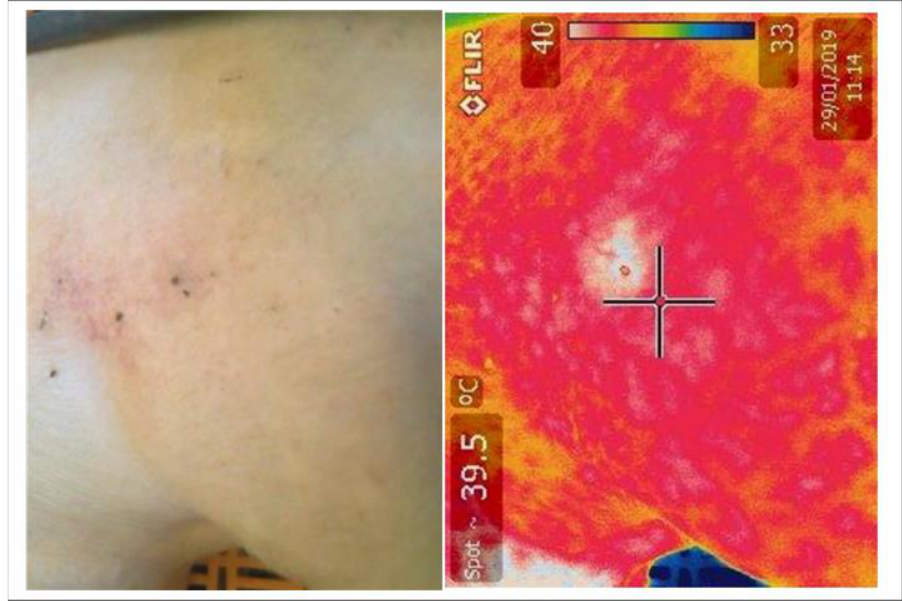
Figure 1. Thermal image of hotspots identified on the shoulder of a sow using FLIR thermal imaging camera.